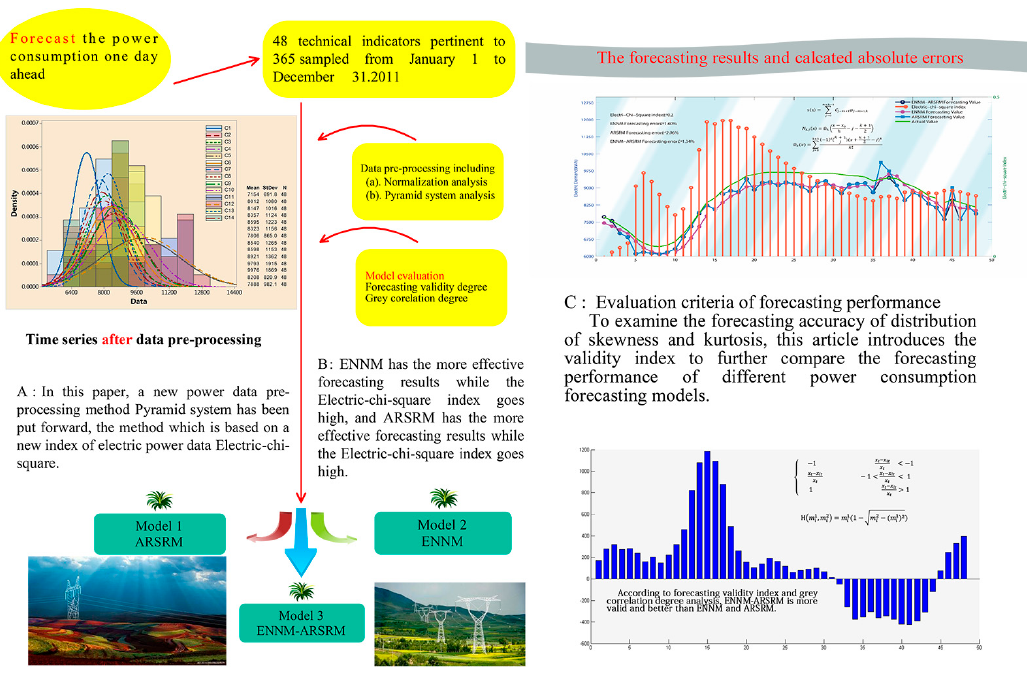
Figure 1. The flowchart of the hybrid model.